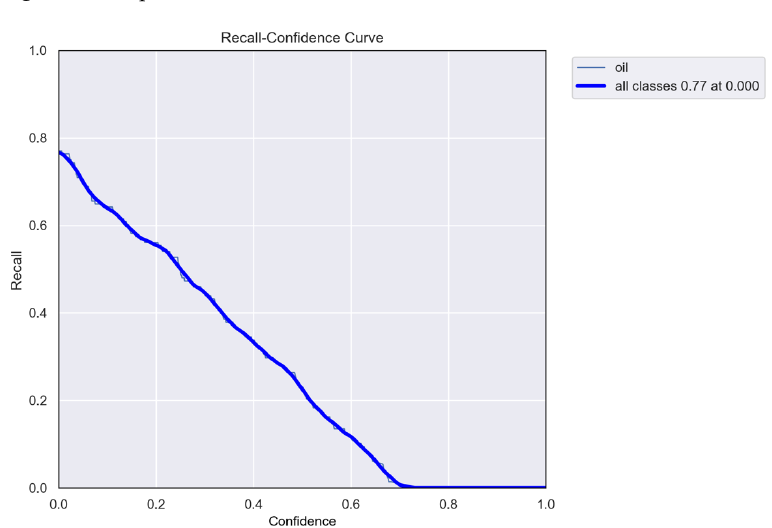
Figure 10. The recall–con fi dence curve.